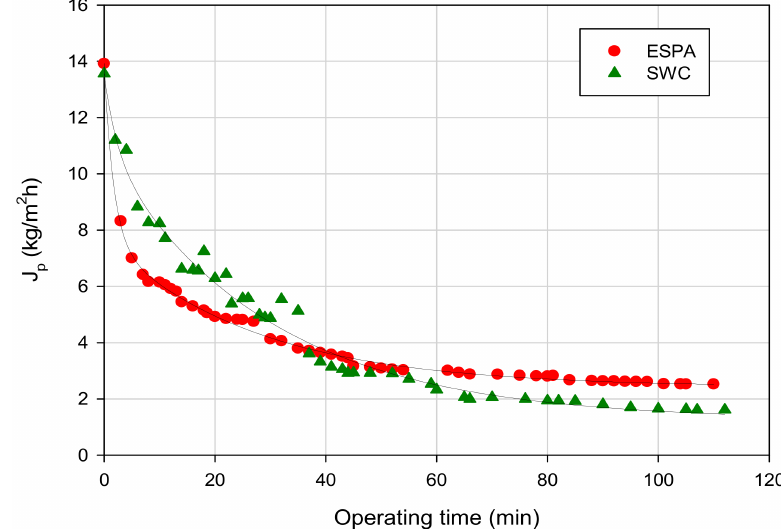
Figure 2. Reverse osmosis (RO) of pre-treated flue gas desulfurization (FGD) wastewaters with selected membranes. Time course of permeate flux. (T, 20 ◦ C; Q f , 220 L/h; recovery factor (RF),